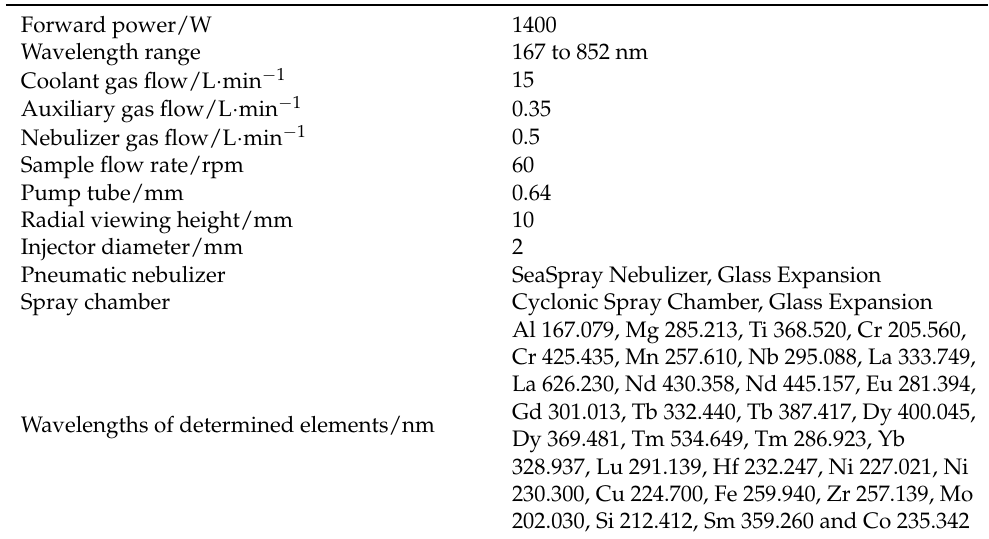
Table 2. Instrumental operating conditions of the optical-emission spectrometer.